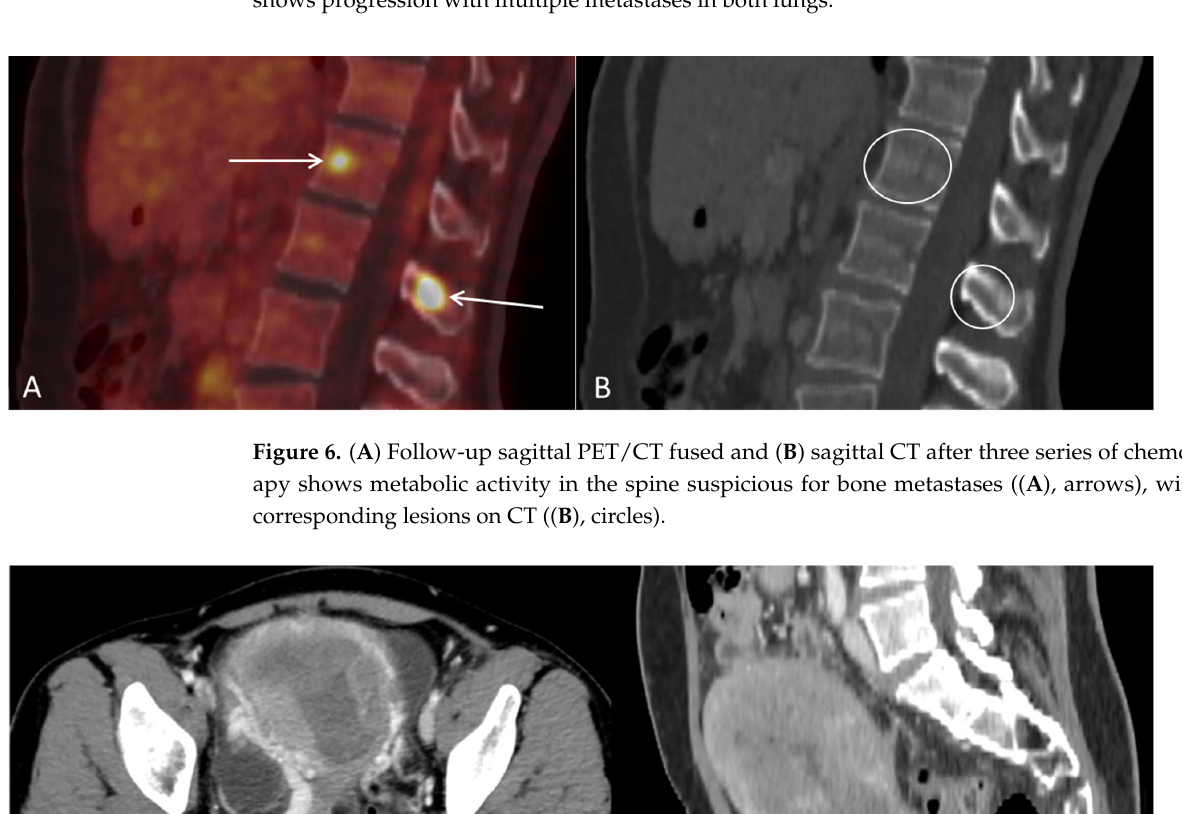
Figure 5. ( A ) Follow-up axial PET/CT fused and ( B ) axial CT after three series of chemotherapy shows progression with multiple metastases in both lungs.